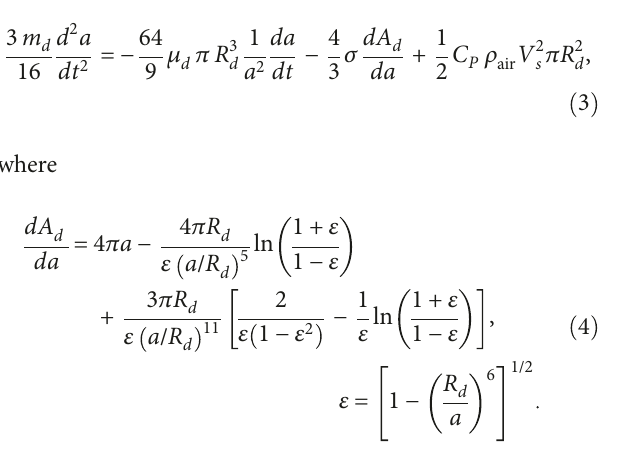
x , y , and a are the droplet horizontal and vertical dis- placements and the droplet maximum half diameter. The other parameters are described in the Nomenclature list. Slip